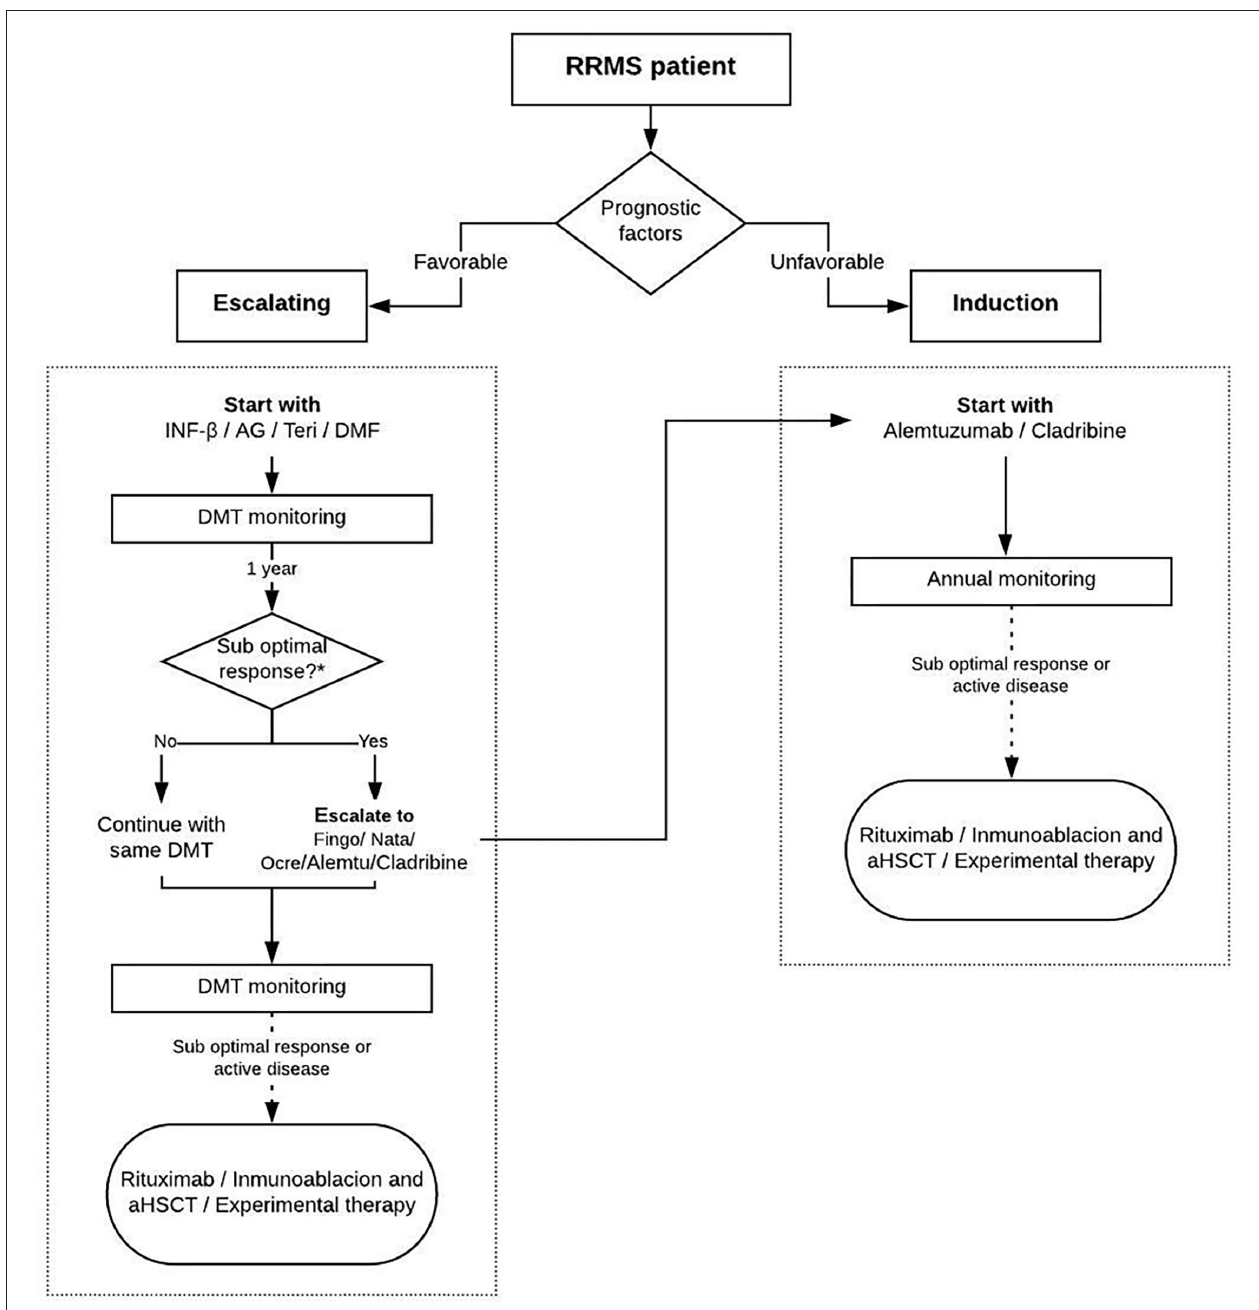
FIGURE 3 | Treatment approach in RRMS. Source: Freedman et al. and Giovannoni et al. (27,